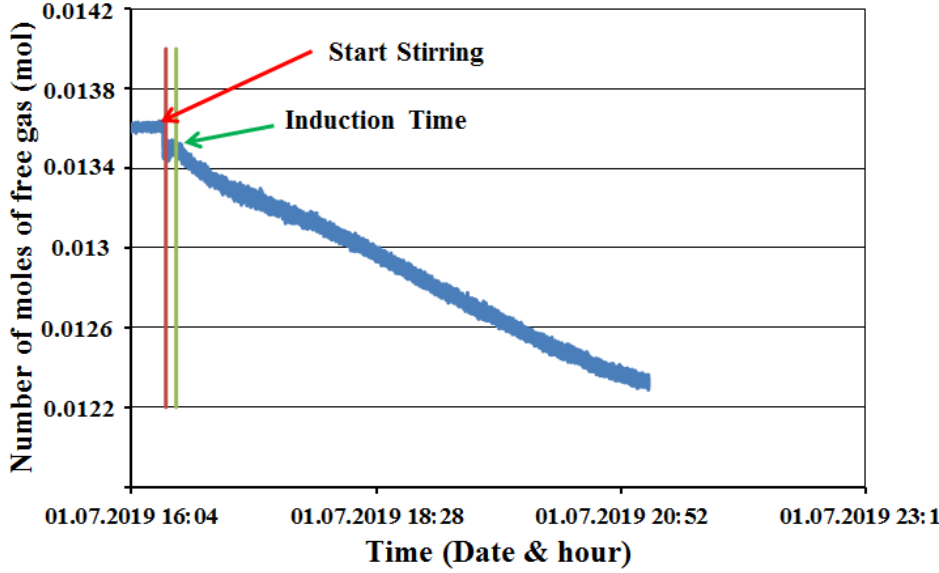
Figure 11. The hydrate formation process of methane single impeller full baffle with the butterfly turbine (CH 4 -SI-FB-BT).